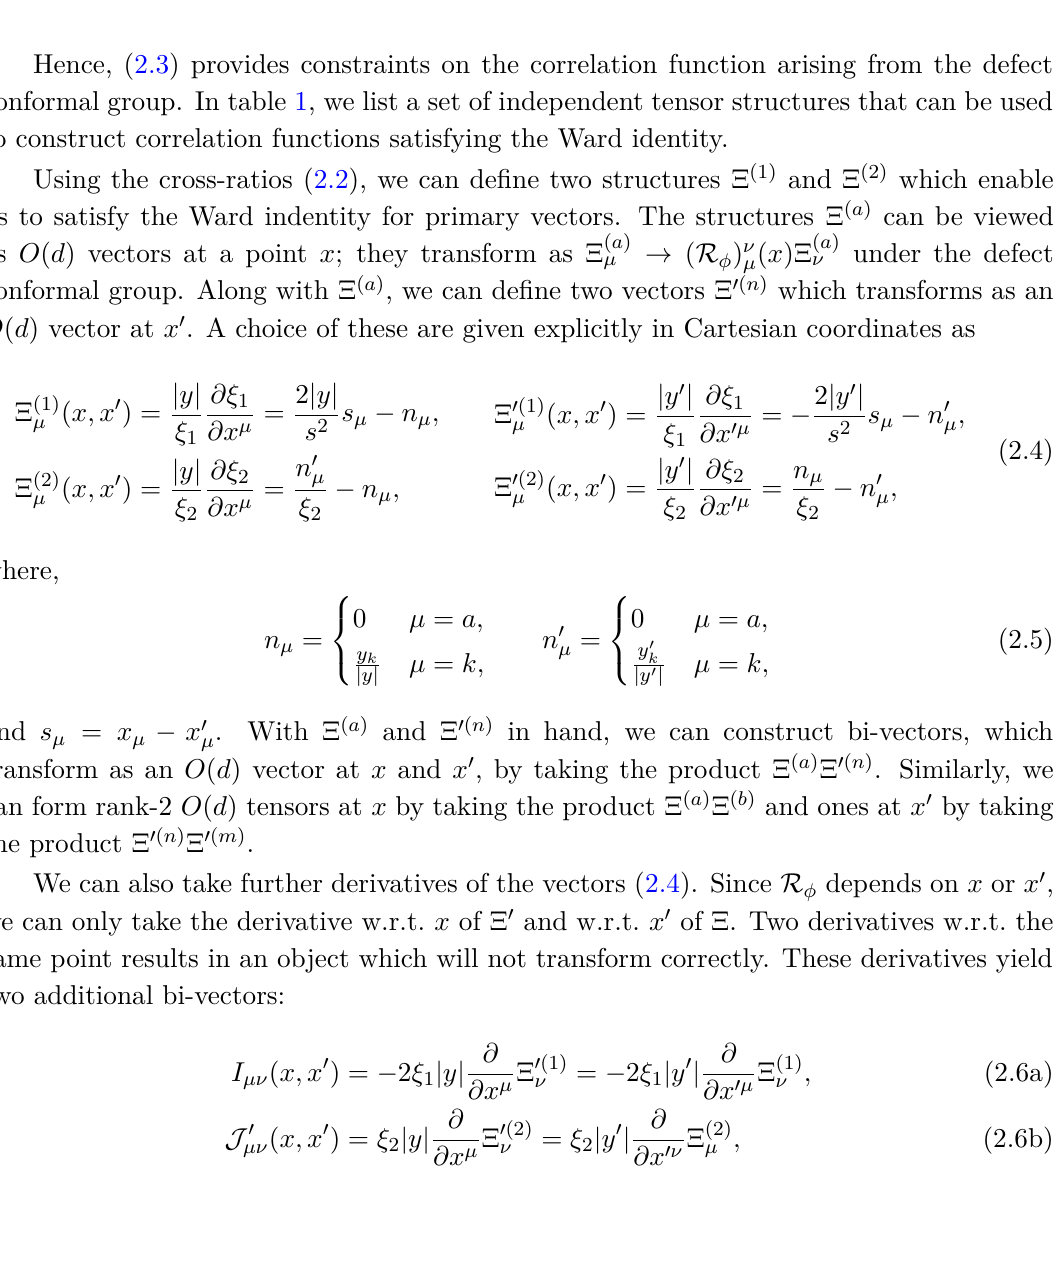
Hence, (2.3) provides constraints on the correlation function arising from the defect conformal group. In table 1, we list a set of independent tensor structures that can be